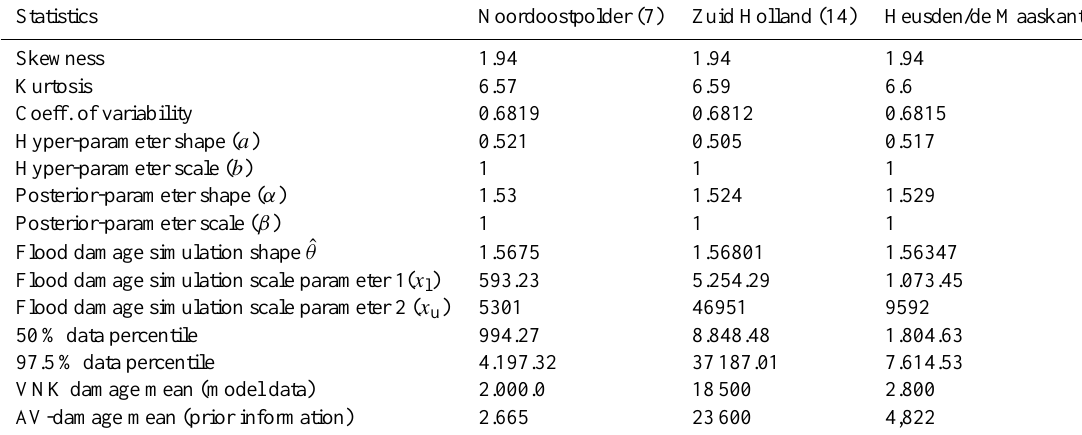
Fig. 5. Simulated flood damage density for the dyke ring Land van Heusden/de Maaskant (36). Table 3. Descriptive statistics (damage is in million euros) of the simulated flood damage densities for dyke ring areas Noordoostpolder (7), Zuid Holland (14) and Heusden/de Maaskant